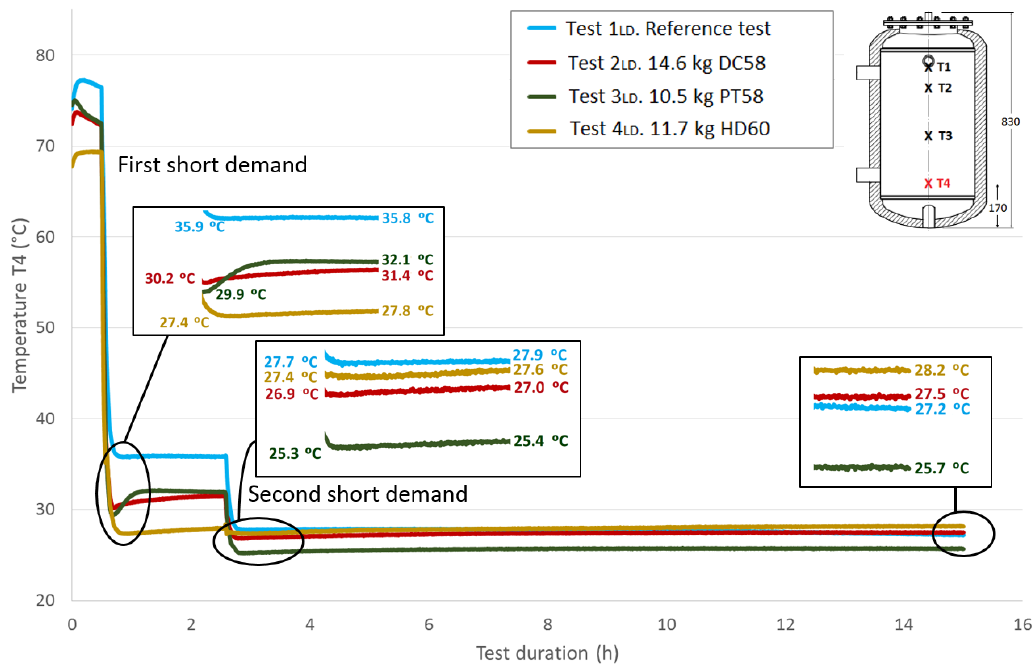
Figure 15. Bottom height water temperature ( T 4) inside the tank during the two shorts demands experiment. (dimensions are in mm).